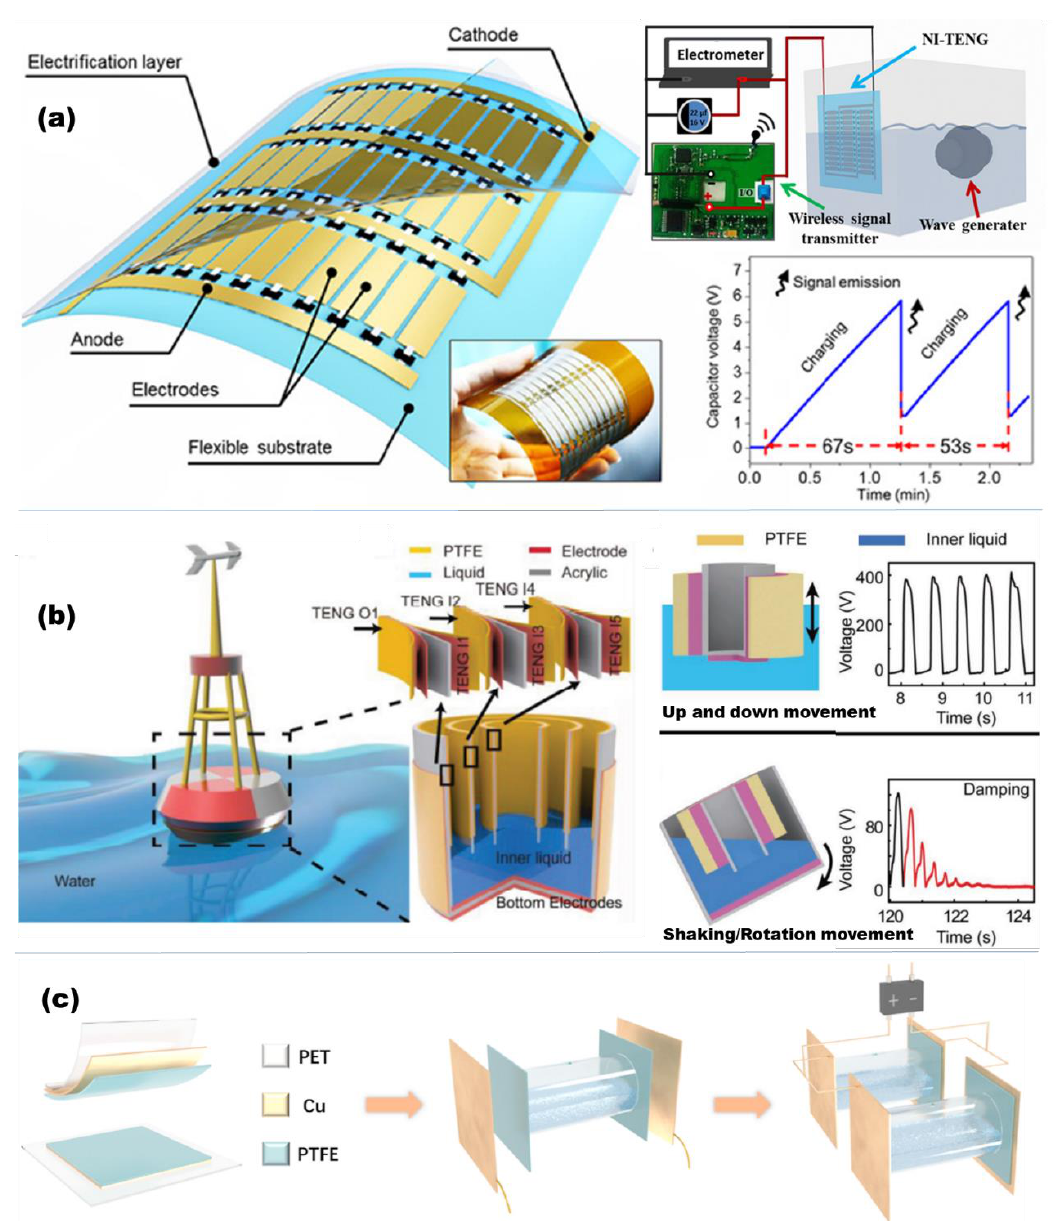
Figure 6. ( a ) The networked-integrated L-TENG and working principle (reproduced with permission from [117]. Copyright 2018 American Chemical Society, New York, NY, USA). ( b ) The buoy-like TENG and electrical characterization (reproduced with permission from [118]. Copyright 2018 WILEY-VCH Verlag GmbH & Co. KGaA, Weinheim, Germany). ( c ) The fabrication procedure and working mechanism of the solid-liquid TENG (reproduced with permission from [130]. Copyright